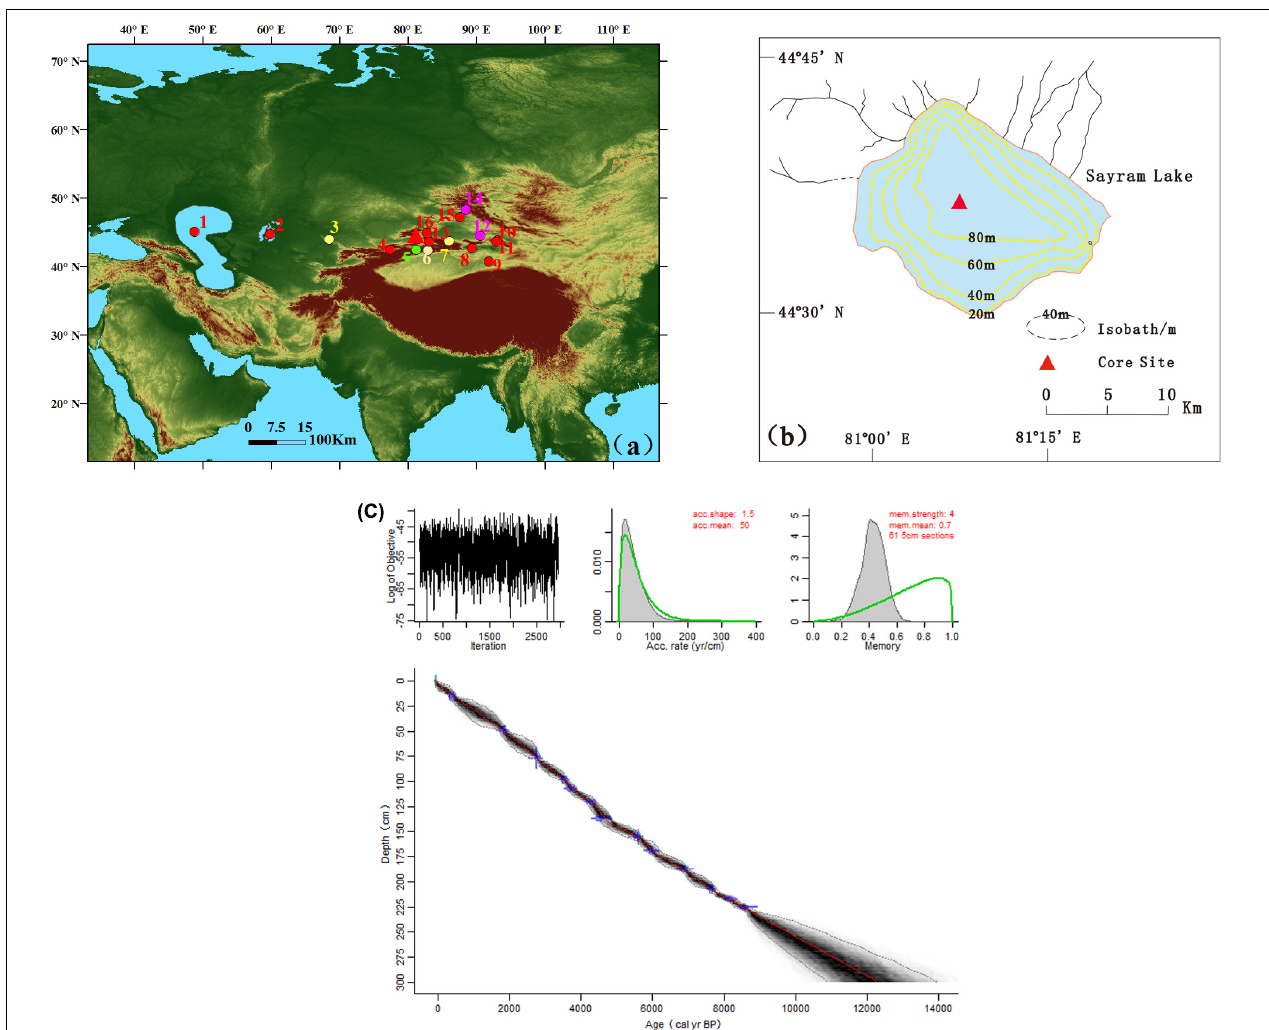
FIGURE 1 | (a) Location map of Sayram Lake (red triangle) and other mentioned and discussed research sites (colored circles with numbers). 1, Caspian Sea (Leroy et al., 2014); 2, Aral Sea (Cretaux et al., 2013); 3, VA loess section in central Kazakhstan (Ran and Feng, 2014); 4, Issyk-Kul in north-western Tianshan Mountains, Kyrgyzstan (Ricketts et al., 2001); 5, Kesang cave stalagmites (Cheng et al., 2012, 2016; Cai et al., 2017); 6, Sand dune in the central TianShan Mountains (Long et al., 2017); 7, LJW loess-paleosol section in the Tianshan Mountains (Chen et al., 2016; Xie et al., 2018); 8, Bosten Lake (Huang et al., 2009); 9, Lop Nur (Liu et al., 2016; Jia et al., 2017); 10, Balikun Lake (An et al., 2011; Zhao et al., 2015); 11, Tuolekule Lake (An et al., 2011); 12, Chaiwopu peat (Hong et al., 2014); 13, Lake sediments profile in Yili Valley (Li et al., 2011; Zhao et al., 2013); 14, Narenxia and Tielisha peat in Altai Mountains (Zhang et al., 2016, Zhang D. et al., 2018); 15, Wulungu Lake (Jiang et al., 2007; Liu et al., 2008); 16, Aibi Lake (Wang W. et al., 2013). (b) The SLM2009 core site (red triangle) and the isobathymetric map of Sayram Lake. (c) Bayesian model age-depth